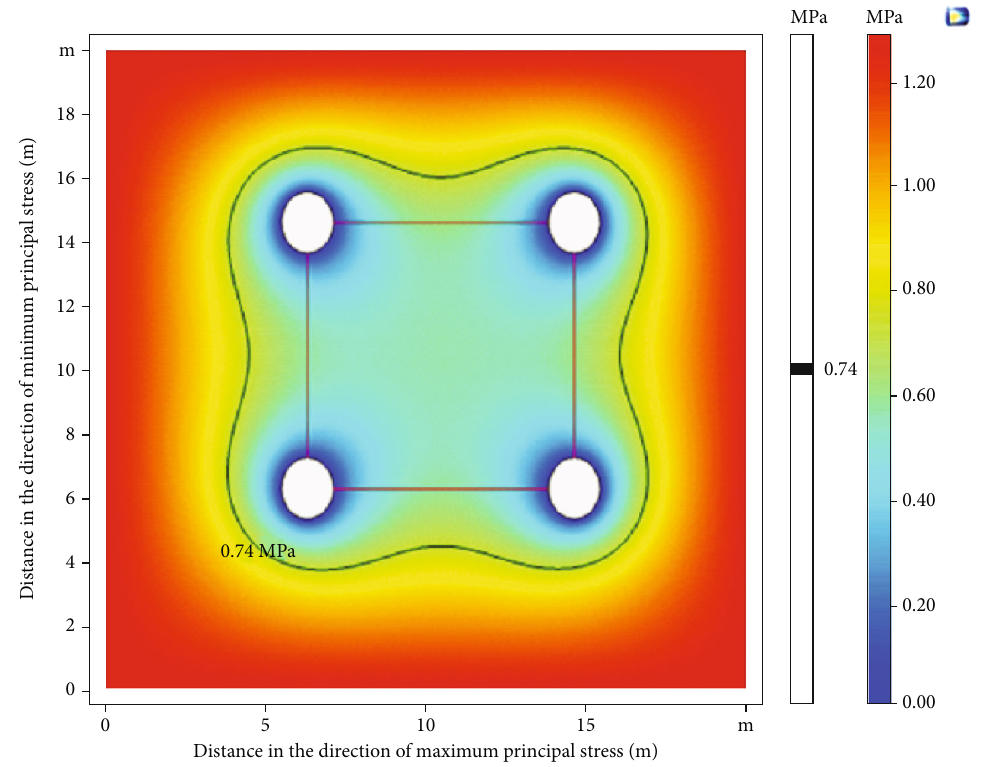
Figure 12: Gas stress distribution map of the maximum horizontal section of the holes that are equivalent to an